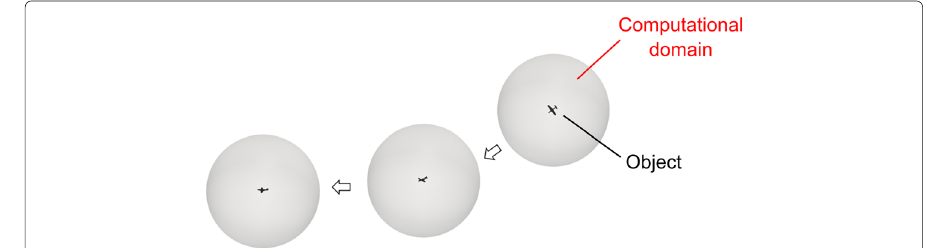
Fig. 2 Moving computational domain of the MCD